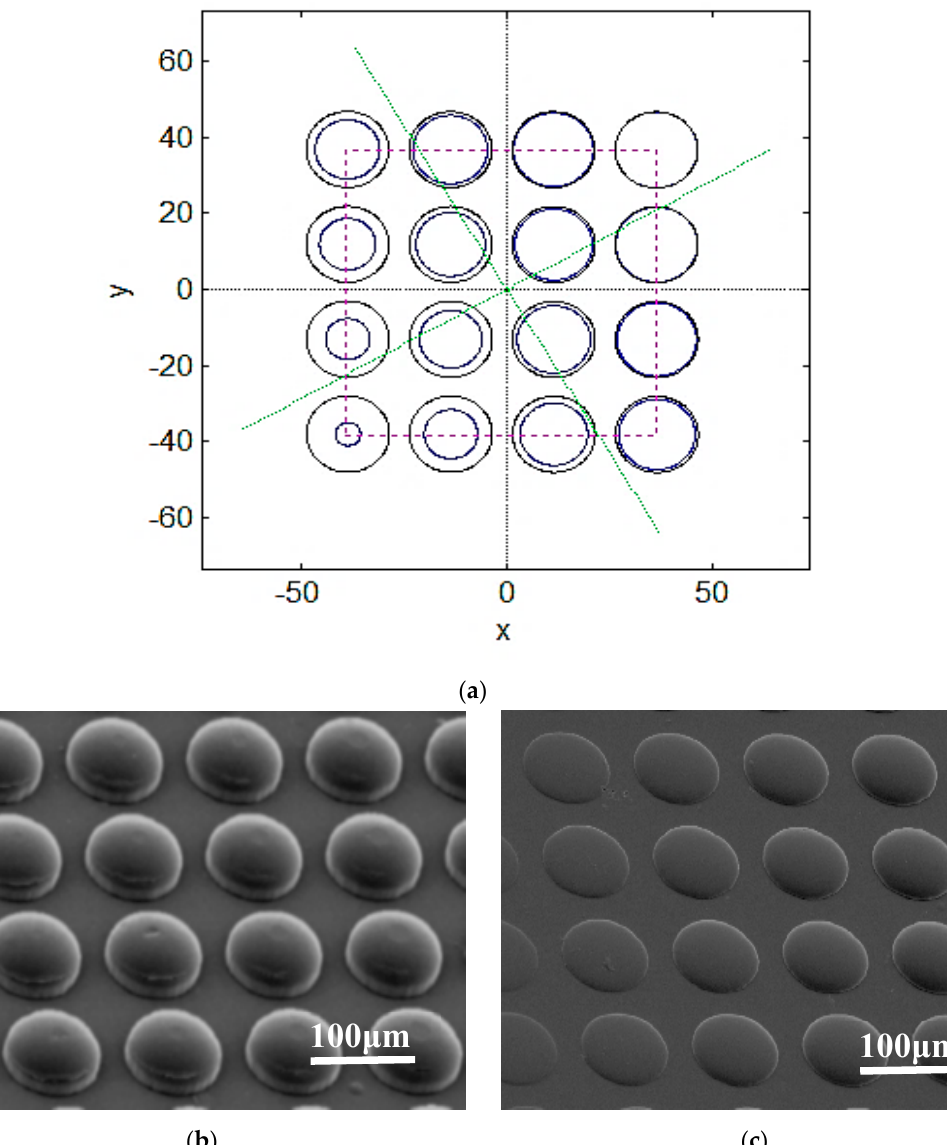
Figure 20. Array microlens hemispherical structure. ( a ) Rotation angle π /6°, tilt angle π /36° MATLAB calculation prediction result; ( b ) rotation angle 0°, tilt angle 0°, actual imprint reproduction result; ( c ) rotation angle π /6°, tilt angle π /36° actual imprint reproduction result.